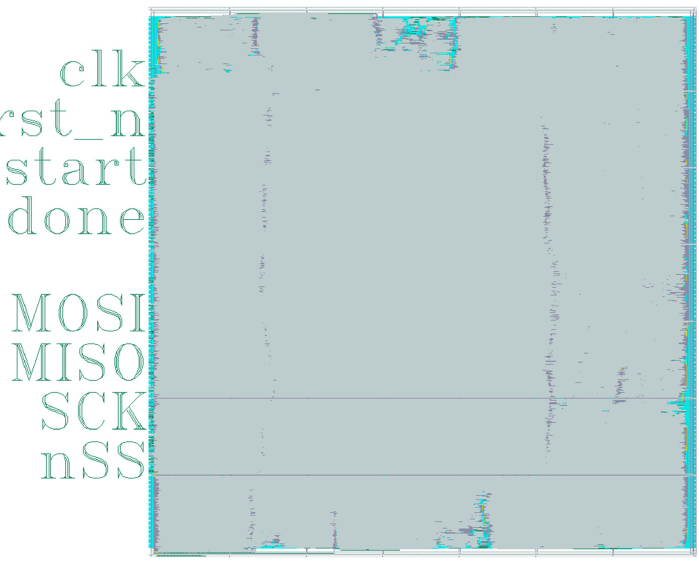
Figure 17. Layout of the accelerator with shared resources.